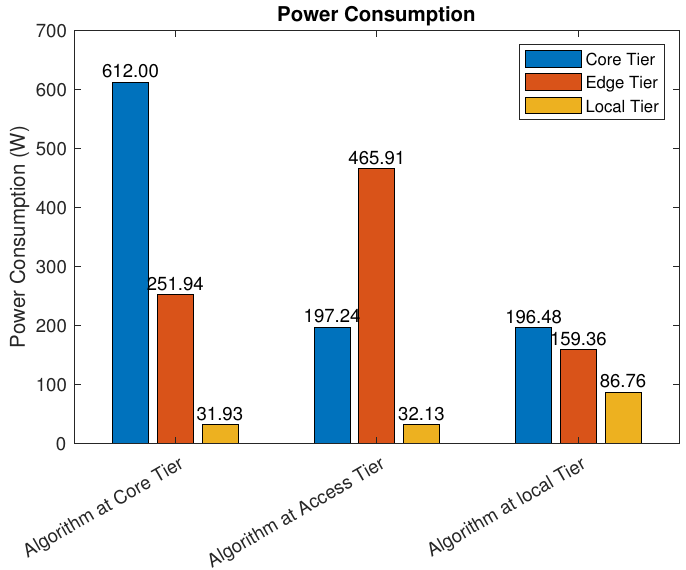
Figure 7. Power consumption: with the